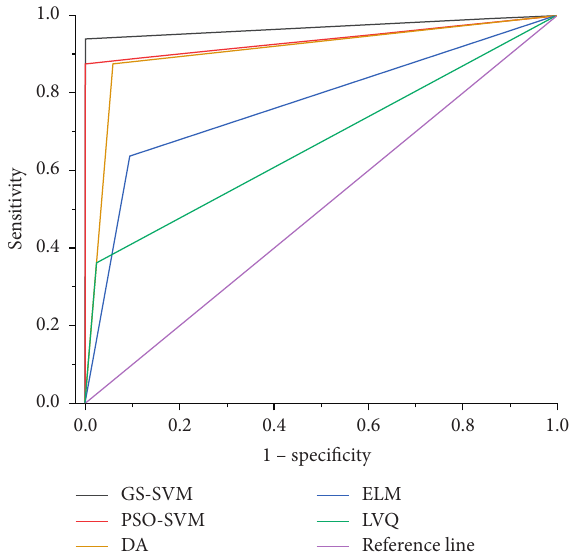
Figure 3: ROC curves of the five models.